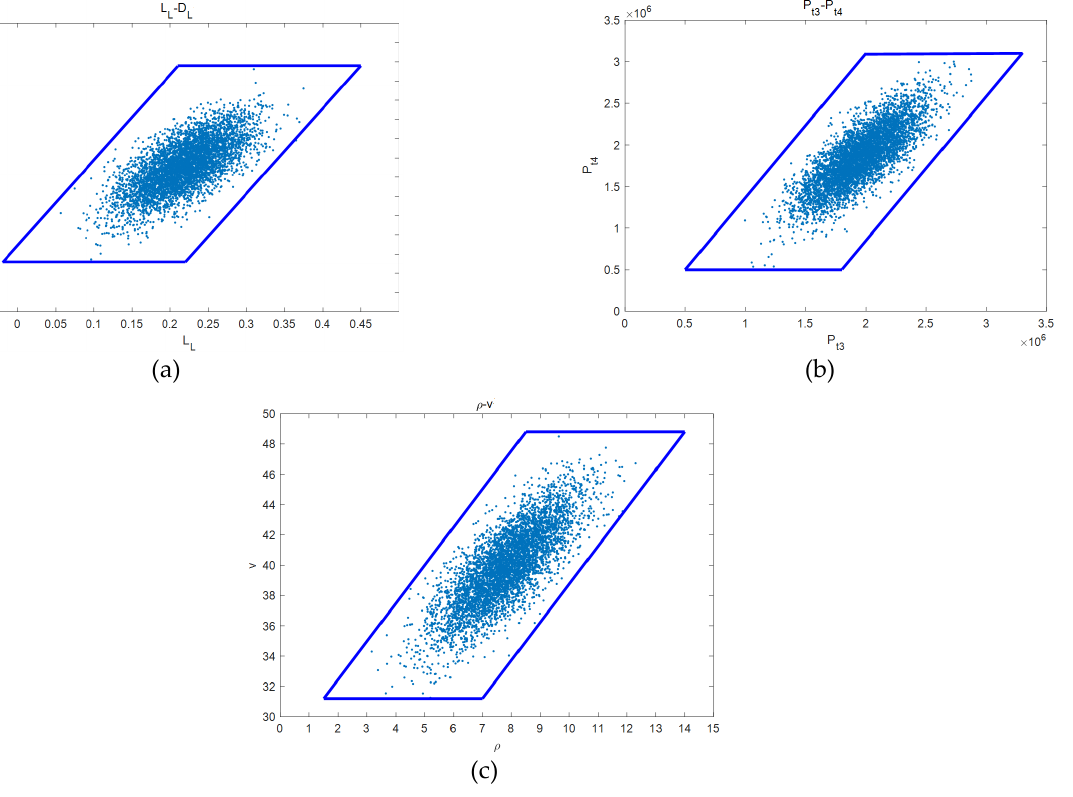
Figure 13. Construct the parallelogram model of the L L − D L , P t 3 − P t 4 and ρ − v plane. ( a ) L L − D L plane; ( b ) P t3 − P t4 plane; ( c ) ρ − v plane. Table 3. Uncertain variable distribution types and parameters for OTDF.